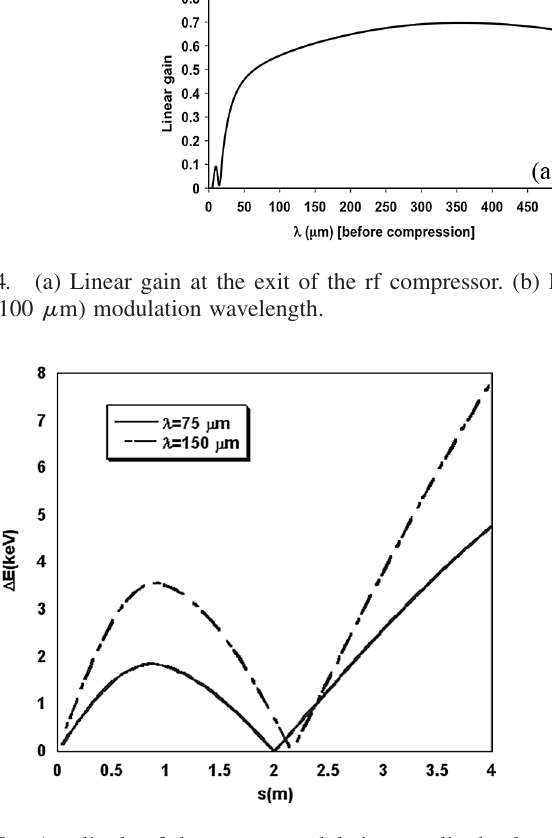
FIG. 5. Amplitude of the energy modulation amplitude along the rf compressor resulting from an initial density modulation with 10% amplitude relative to an initial current I Other beam and rf compressor parameters are as in Figs. 3 and